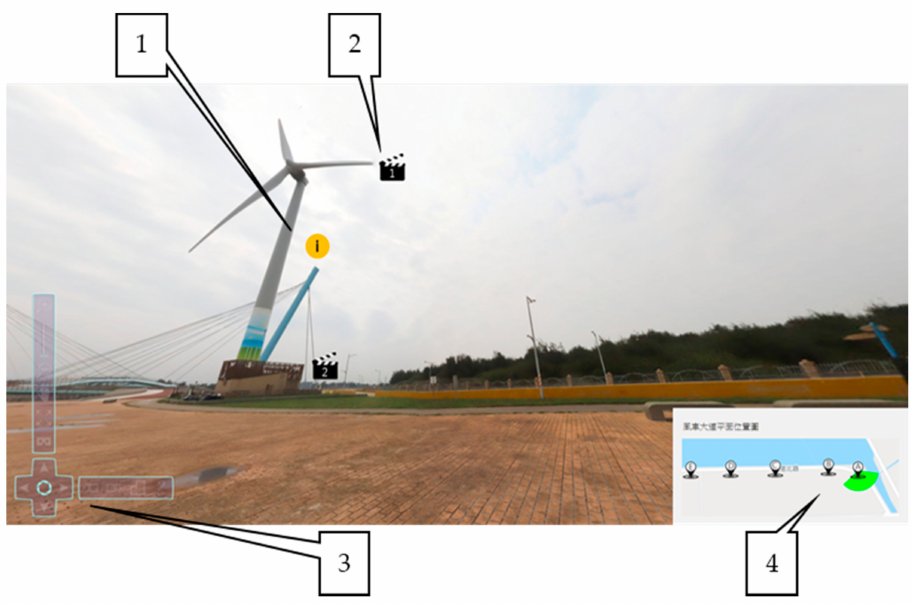
Figure 10. Main station (Station A) of the developed virtual tour environment. Symbol 1: more information, Symbol 2: video for illustration, Symbol 3: control bar, Symbol 4: guide